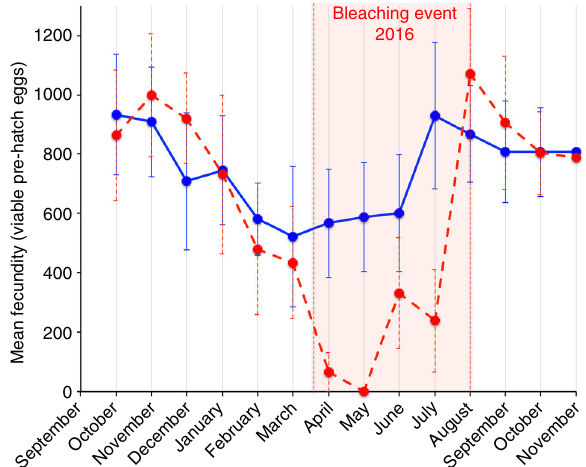
Fig. 4 Anemone fi sh fecundity over time including the bleaching event. Effect of exposure to warming-induced anemone bleaching ( vertical red lines and shading ) on the monthly fecundity (number of viable pre-hatching eggs) of wild, free-living adult anemone fi sh over 14 months from October 2015 through November 2016. Pre-hatching fecundity of anemone fi sh exposed to unbleached ( n = 7, blue ) and bleached ( n = 6, red ) anemones before and during the bleaching event (GLM with repeated